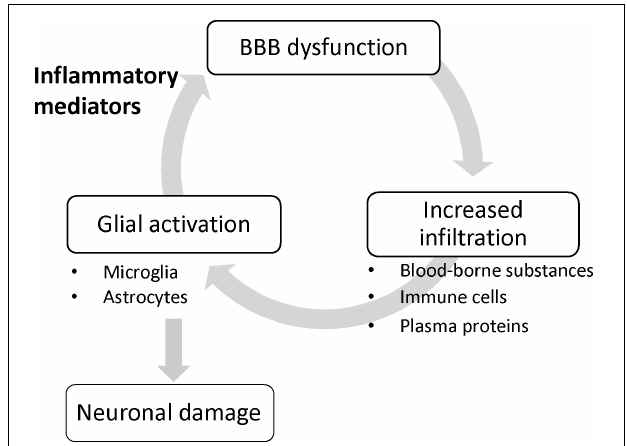
FIGURE 1 | BBB dysfunction amplifies glial activation. Once glial cells are activated without any impairment of the brain endothelial barrier function, glial activation triggers BBB dysfunction through the release of inflammatory mediators, and in turn, the leaky BBB allows infiltration of blood-borne inducers of glial activation into the brain, resulting in aggravated glial